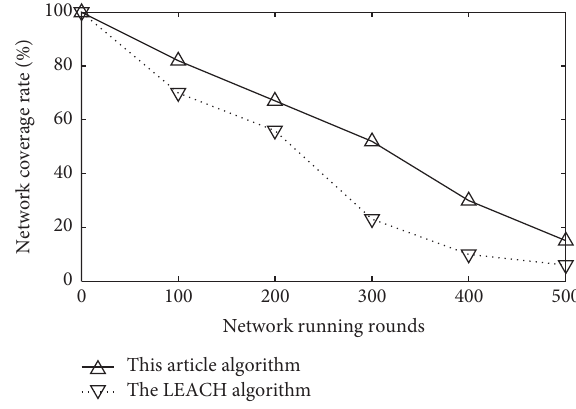
Figure 1: Network coverage rate comparison in this article’s al- gorithm and the LEACH algorithm under different network running rounds (when s � 0.05).